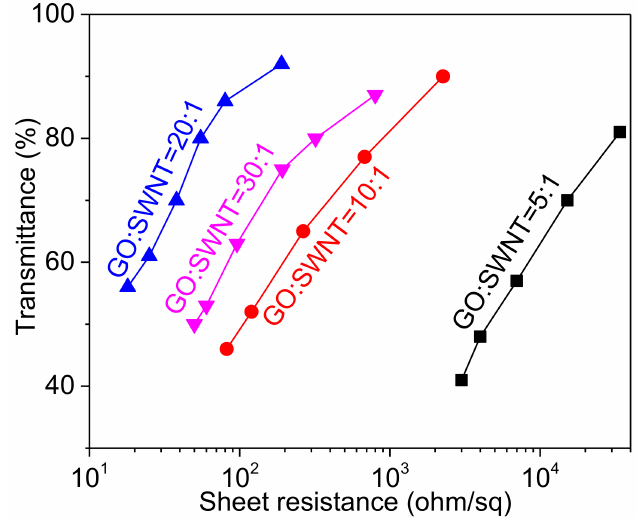
Figure 7. Sheet resistance versus optical transmittance for rGO-SWNT films fabricated from inks with different GO to SWNT mass ratios. The SWNT content in the ink is 0.2